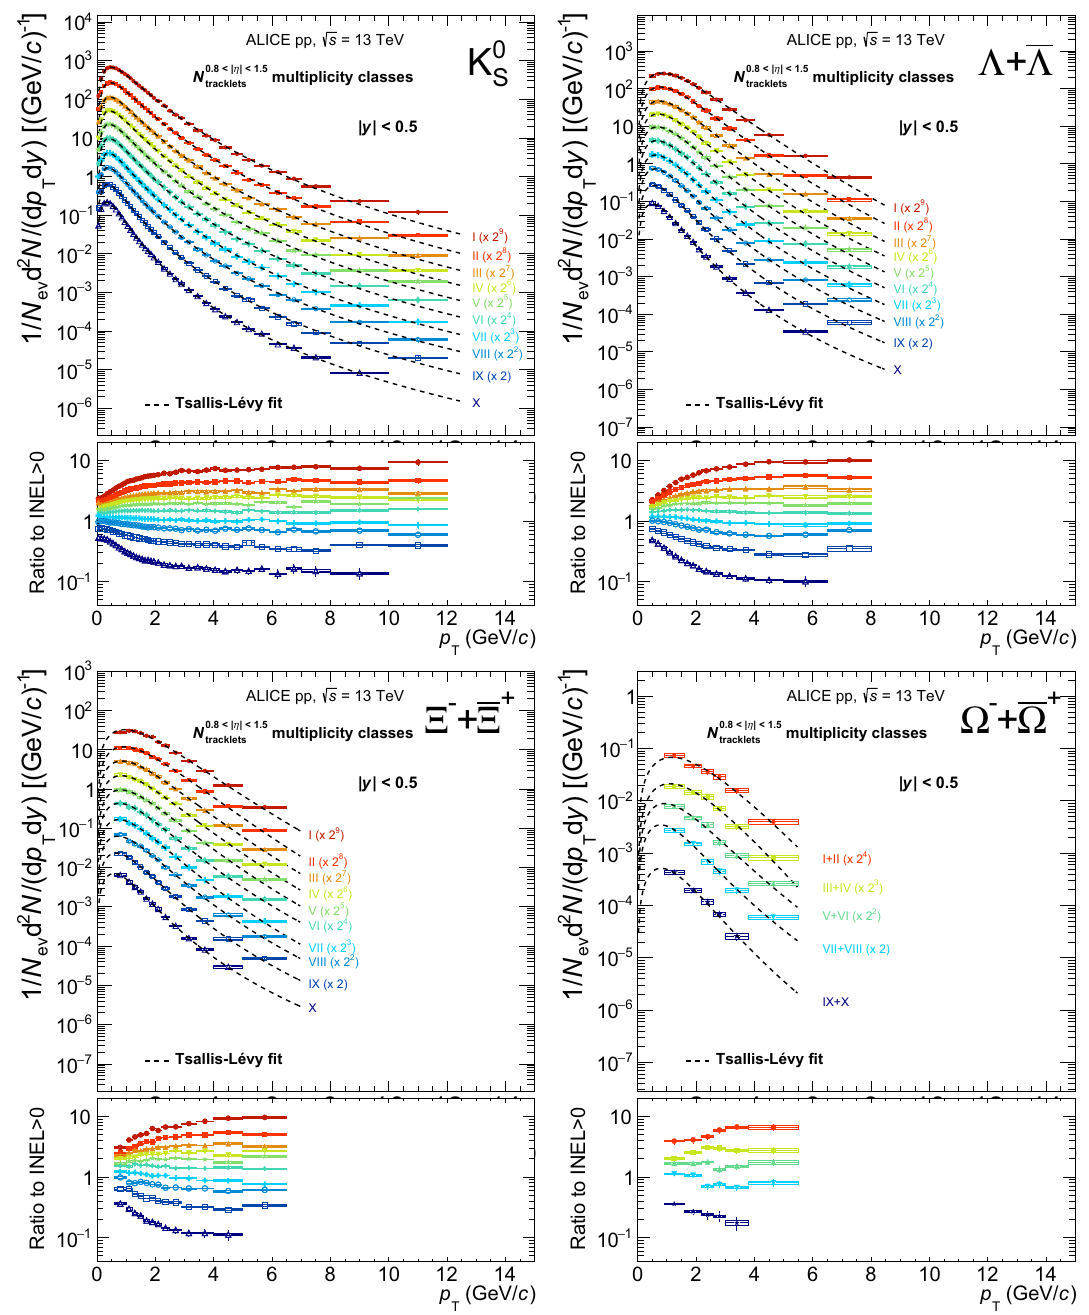
Fig. 4 Transverse momentum distribution of K 0 the ratios are obtained by considering only contributions uncorrelated , (cid:3) , (cid:4) , and (cid:5) , for S acrossmultiplicity.Thespectraarescaledbydifferentfactorstoimprove multiplicity classes selected using the tracklets in 0 . 8 < | η | < 1 . 5. Sta- the visibility. The dashed curves represent Tsallis–Lévy fits to the mea- tistical and total systematic uncertainties are shown by error bars and sured boxes, respectively. In the bottom panels ratios of multiplicity depen- dent spectra to INEL > 0 are shown. The systematic uncertainties on